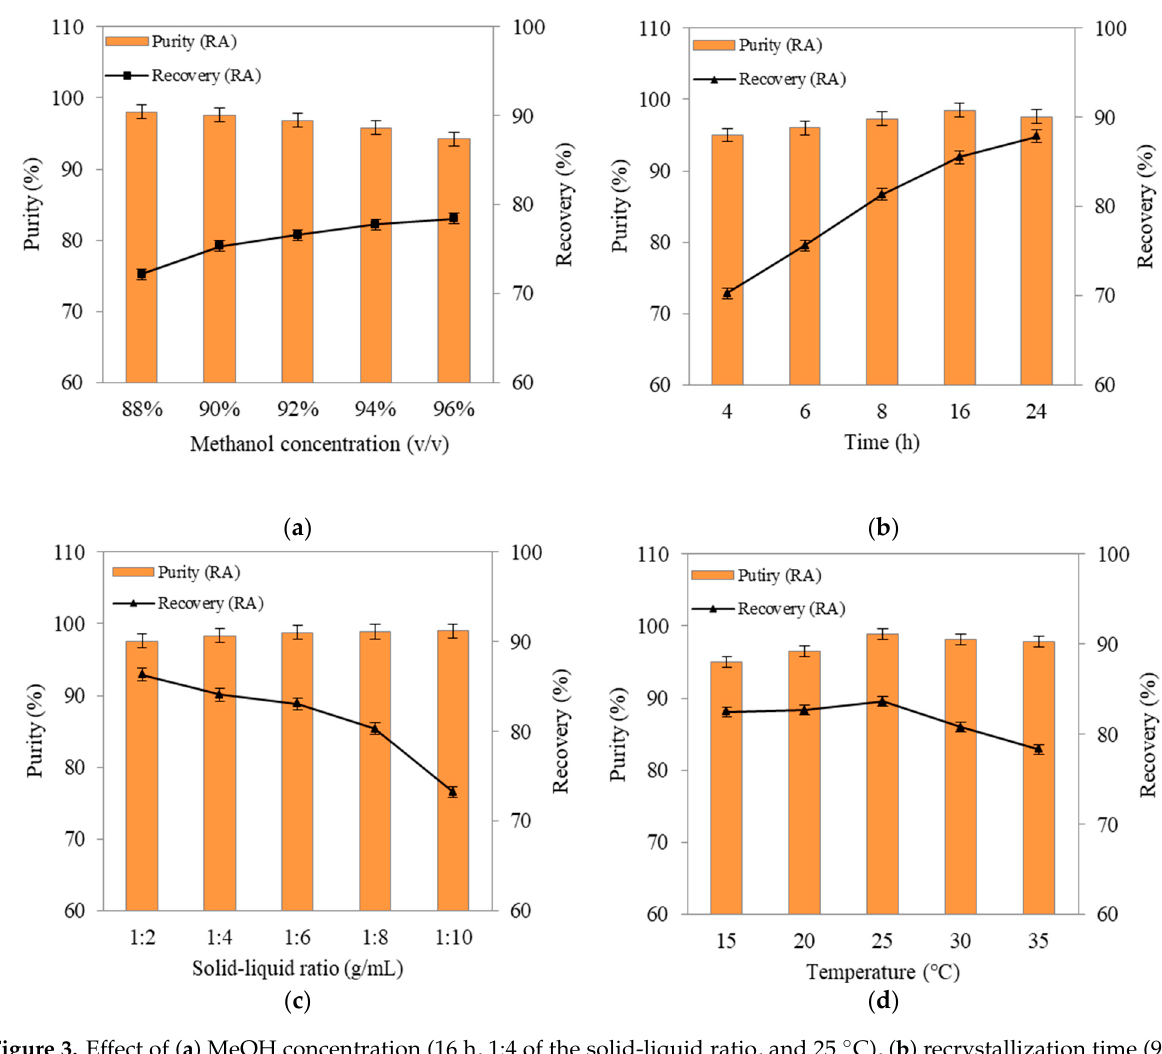
Figure 2. Solvent effect on purity and recovery of RA.